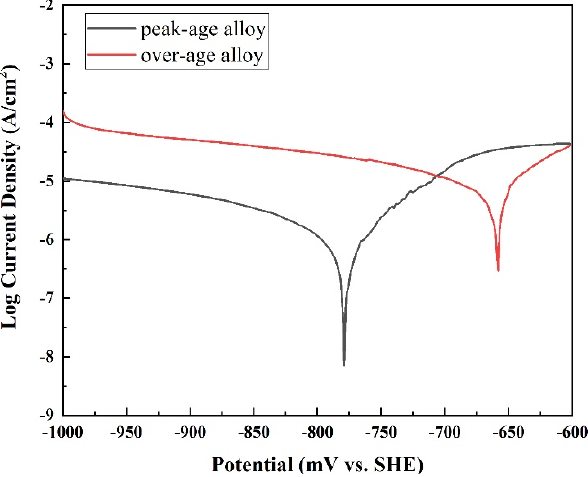
10 of 13 Figure 11. TEM (Transmission Electron Microscope) images of the aged alloy: microstructural morphology of ( a ) nano-scale precipitates of θ ', T1 and δ ’, and ( b ) Al 20 Cu 2 Mn 3 phase in the aged alloys. 3.3. Corrosion Performance Figure 12 showed typical Tafel curves of the peak-age alloy and over-age alloy, which was first aged at 120 °C for 4 h and then aged at 180 °C for 16 h. Tafel polarization param- eters are shown in Table 4. E corr represents the corrosion potential of alloy corrosion, and I corr represents corrosion current density. It could be found from Figure 12 that the Tafel curves of different aged alloys were typical Tafel curves of aluminum alloys. The higher